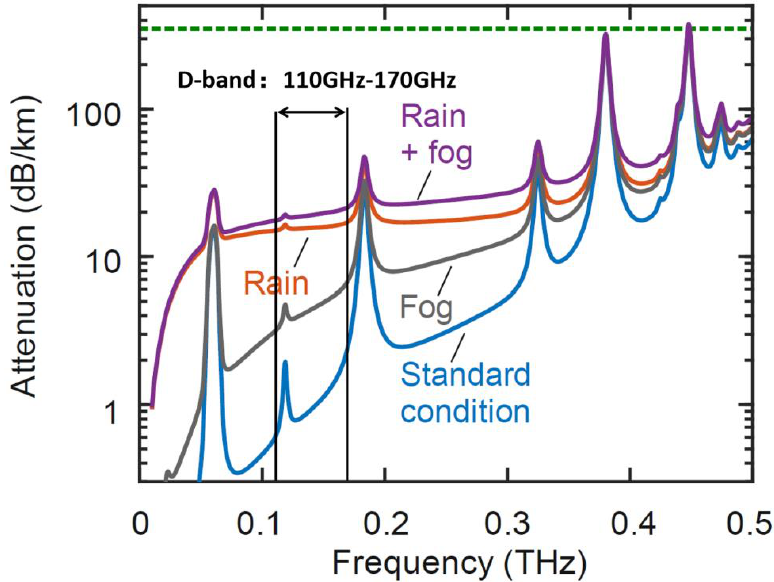
Figure 1. Free-space path atmospheric attenuation.